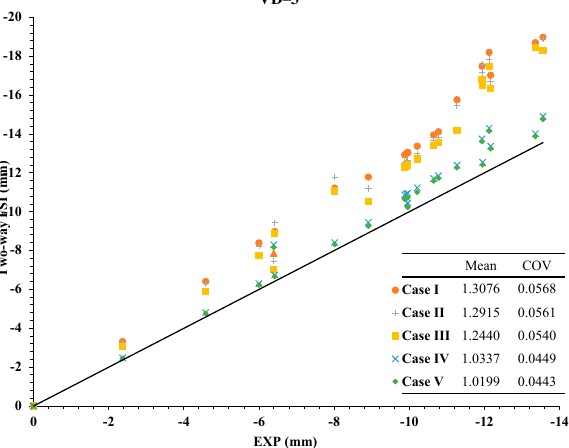
Figure 28. Statistical analysis of two-way FSI for deflection versus time increments ( ∆𝑡 ) at VD-3.